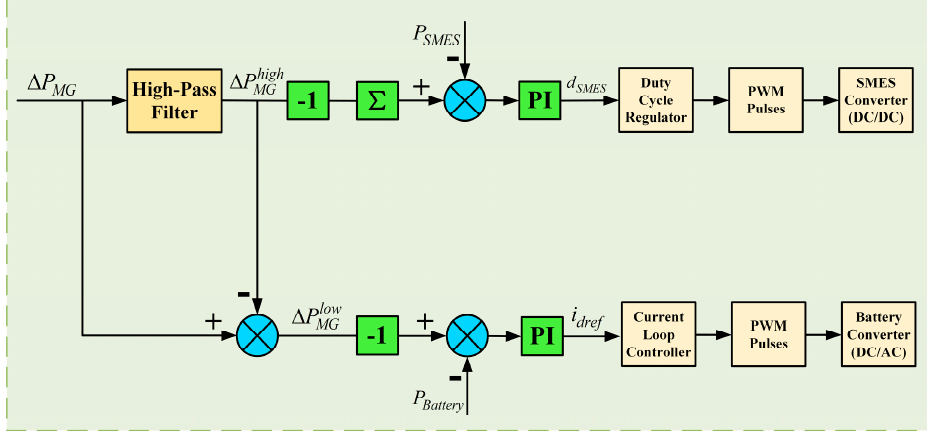
Figure 3. Control strategy for the HESS.